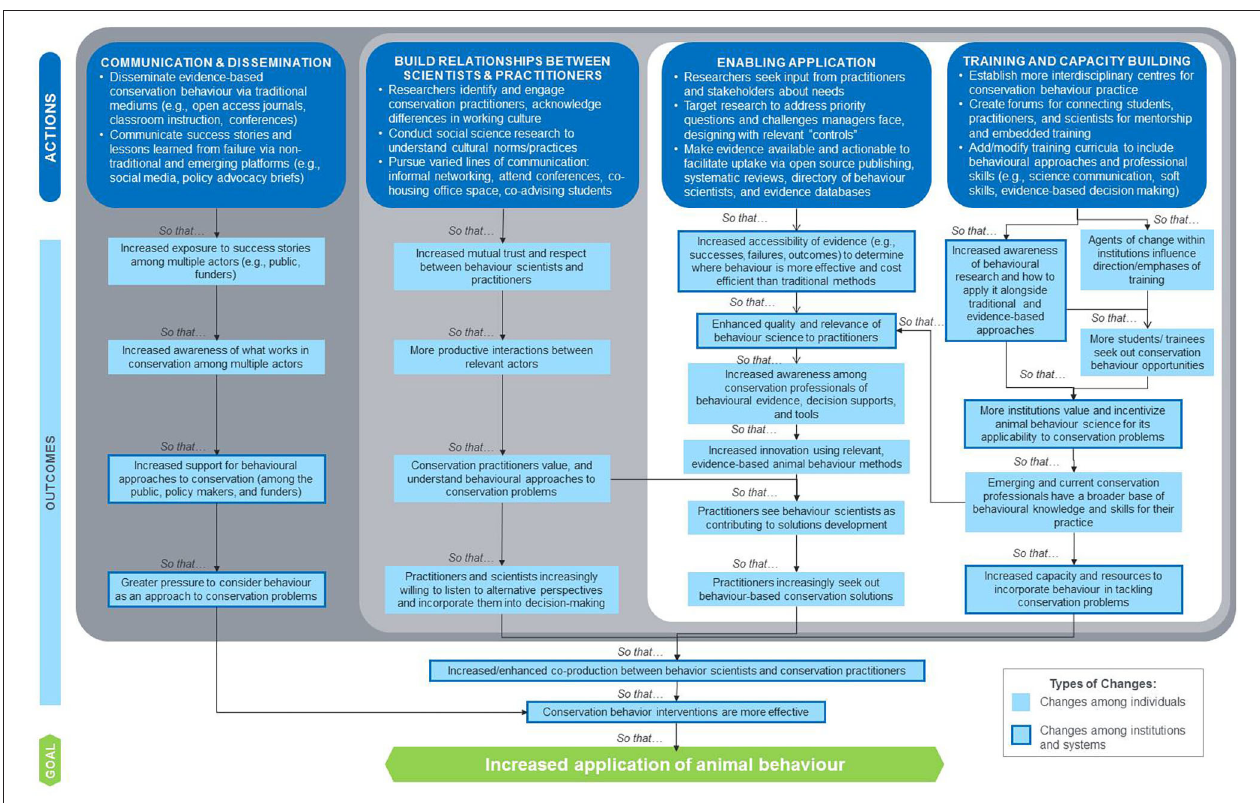
FIGURE 1 | Change model diagram. The model contains four interdependent strategies, nested on three levels. The outermost level (dark gray) sets the landscape for the other strategies, by depicting activities that promote effective communication and dissemination of success, thereby creating a supportive environment for other strategies. The intermediate level (light gray) targets a strengthening of relationships between conservation behavior scientists and practitioners. The innermost level (white) captures the interplay between institutions that enhance training and capacity building, and the infrastructure for making science available. Each strategy outlines a series of actions (dark blue boxes) whose pursuit leads to a logical series of